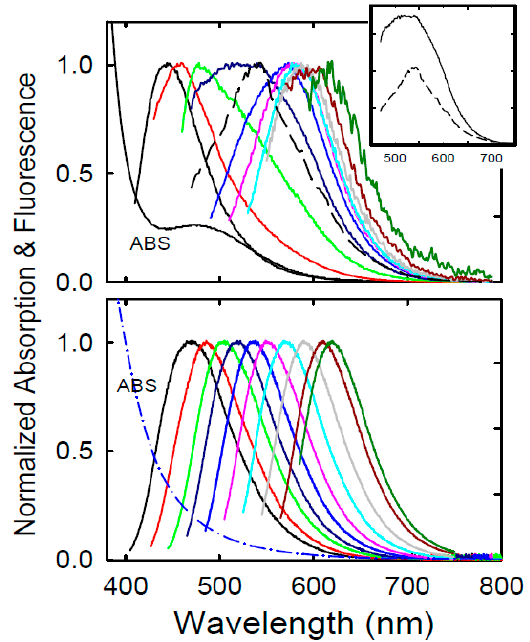
Figure 3. Upper: Absorption (ABS) and normalized fluorescence spectra at different excitation wavelengths (from 400 to 580 nm in the 20 nm increment) of the as-supplied MilliporeSigma sample solution. The fluorescence spectrum at 460 nm excitation in the presence of 0.15 M 2,4-dinitrotoluene as quencher is shown in the same normalized scale (dash line), and also in the insert in the relative intensity scale for comparison. Lower: Absorption (ABS) and fluorescence spectra at different excitation wavelengths (from 400 to 580 nm in the 20 nm increment) of EDA-CDots in aqueous solution.